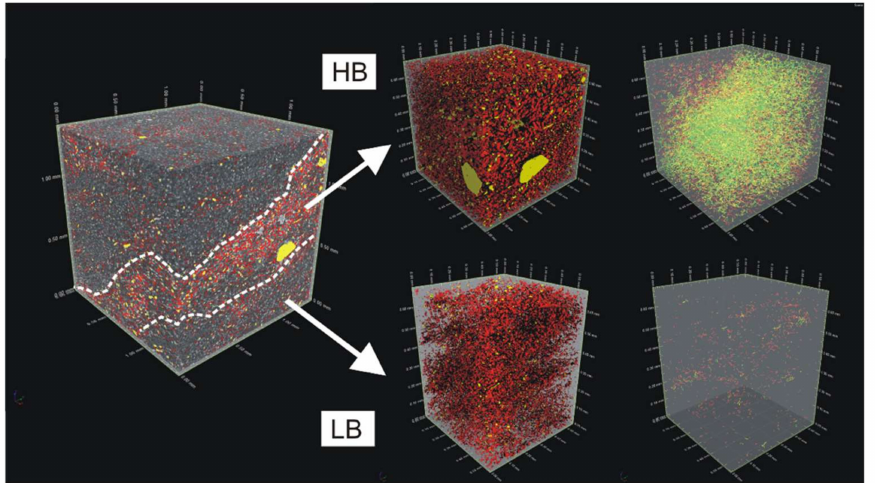
Figure 3. The reconstructed 3D volume of interest (2.57 mm 3 ) of the TR1 sample showing a banded ap- pearance given by HB (high skeleton complexity) and LB (low skeleton complexity) zones. Skeletons evidence different connectivity for the vesicle network in HB compared to LB.